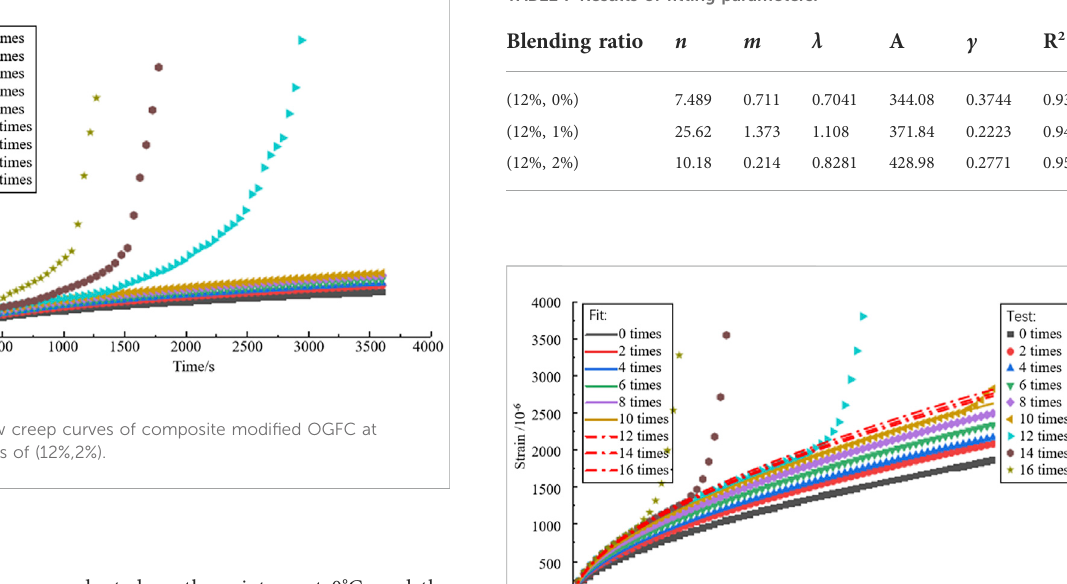
TABLE 7 Results of fi tting parameters.